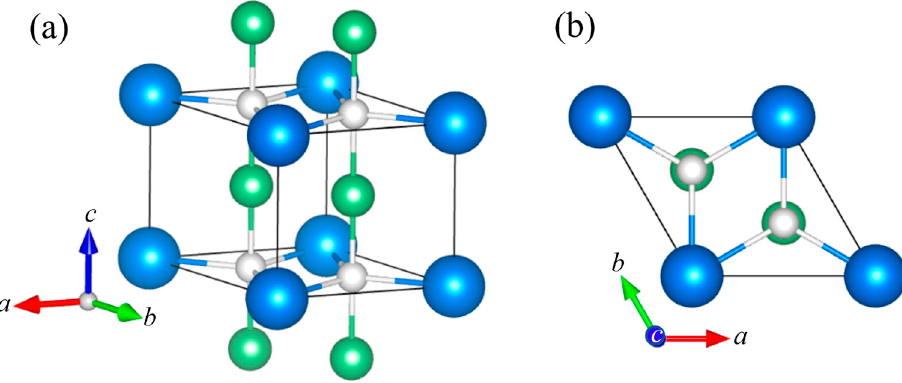
Figure 1. ( a ) Hexagonal P 6/ mmm crystal structure of ZrBe 2 H x . Blue, green, and white spheres represent Zr, Be, and H, respectively. Alternate ab -planar layers of Zr and Be atoms form the parent ZrBe 2 structure with H atoms occupying at random the trigonal Zr 3 (2 c ) sites of the Zr plane and further straddled by Be atoms directly above and below along the c -axis. For ZrBe 2 H x , 2 c site occupation is x /2. Full H site occupation corresponds to the theoretical compound ZrBe 2 H 2 . For x = 1.5, the H site occupation is 0.75. ( b ) View along the c axis, starting from the Zr layer surface.